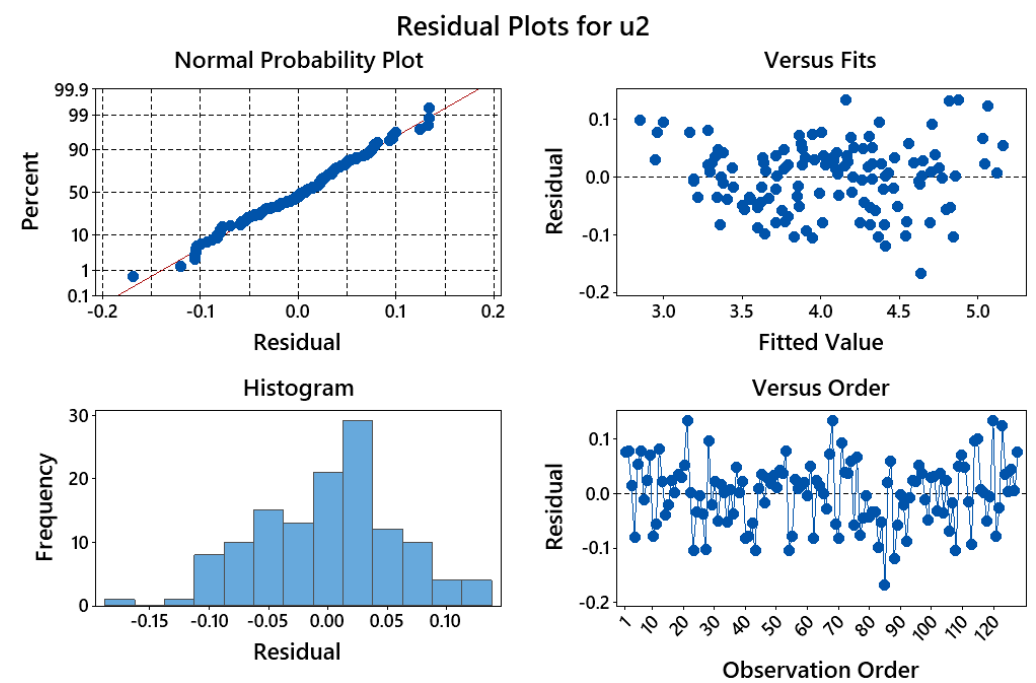
Figure 7. Graphs estimating errors between experiments and model of u 2 .